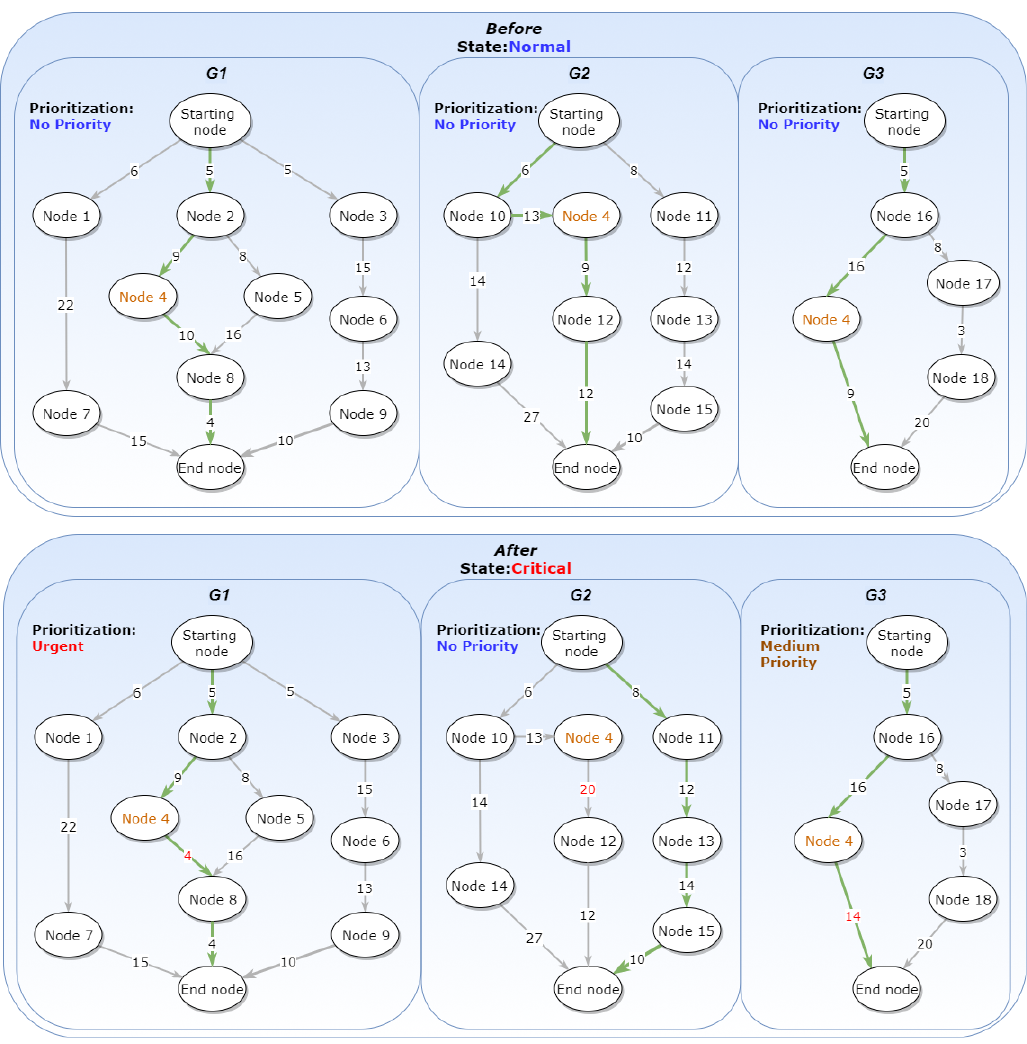
Figure 19. Prioritization Use